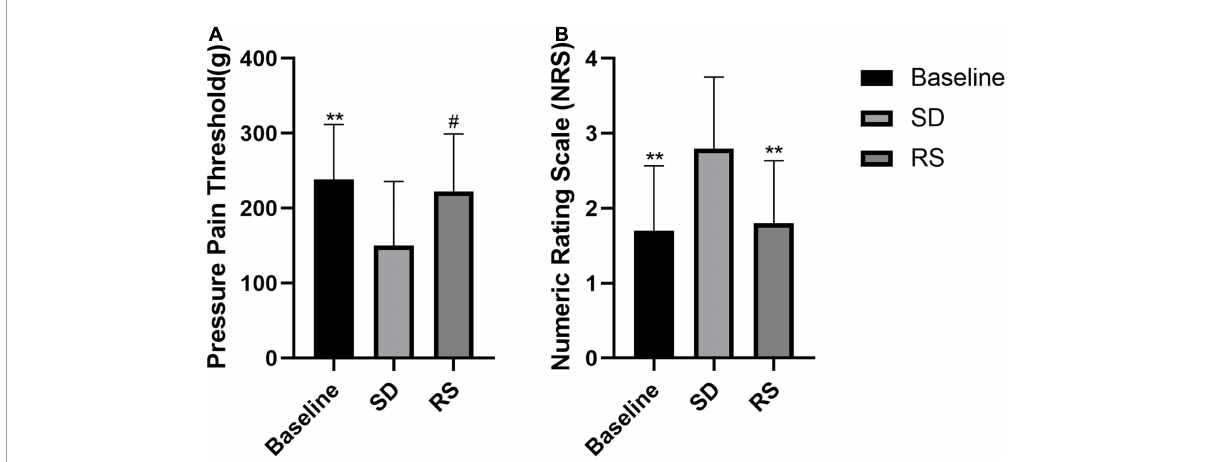
FIGURE3 Pressure pain threshold (A) and NRS subjective pain scores (B) . Subjects’ changes in pressure pain threshold and subjective NRS scores. Sleep deprivation (SD) significantly increased perceived pain compared to baseline, and this nociceptive hyperalgesia was significantly reduced after recovery sleep (RS). # P < 0.05 compared to SD. ** P < 0.01 compared to SD.